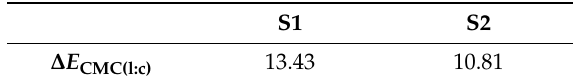
− 0.04 The color difference ( ∆ E CMC(l:c) ) after 50 washes for electrodes coated by the two PEDOT:PSS solution: S1 S2 ∆ E CMC(l:c) 13.43